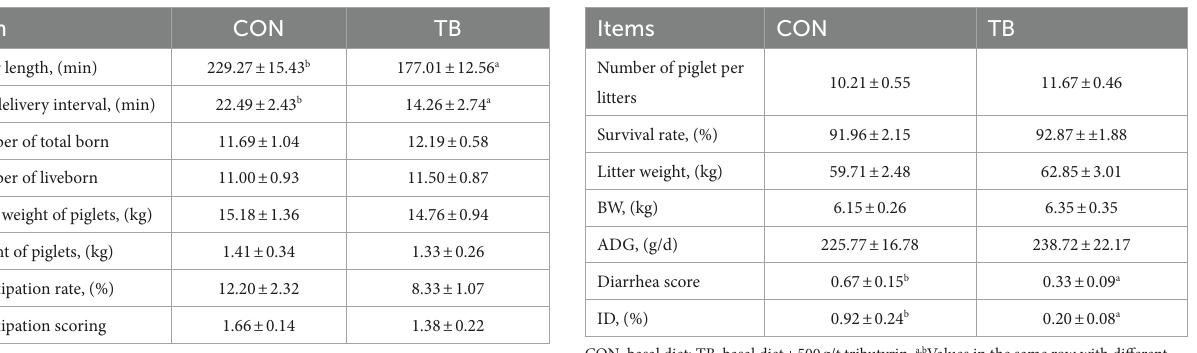
TABLE 3 Effects of tributyrin on growth performance of weaning piglets. TABLE 1 Effects of tributyrin on delivery performance and fecal score of sows.